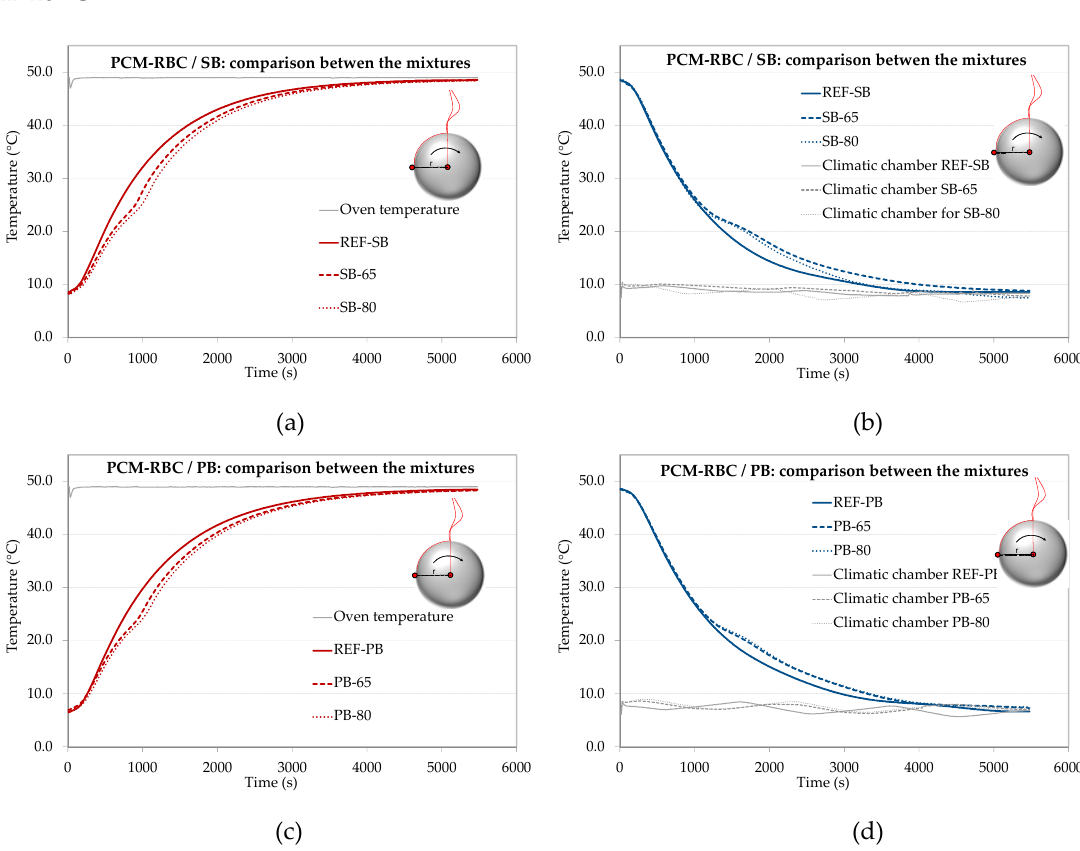
Figure 3. Temperature evolutions of the DKK tests: ( a ) heating and ( b ) cooling of PCM-RBA mortars with SB bricks, ( c ) heating and ( d ) cooling of PCM-RBA mortars with PB bricks. These results represent the average of three measurements in the center of the spherical samples.